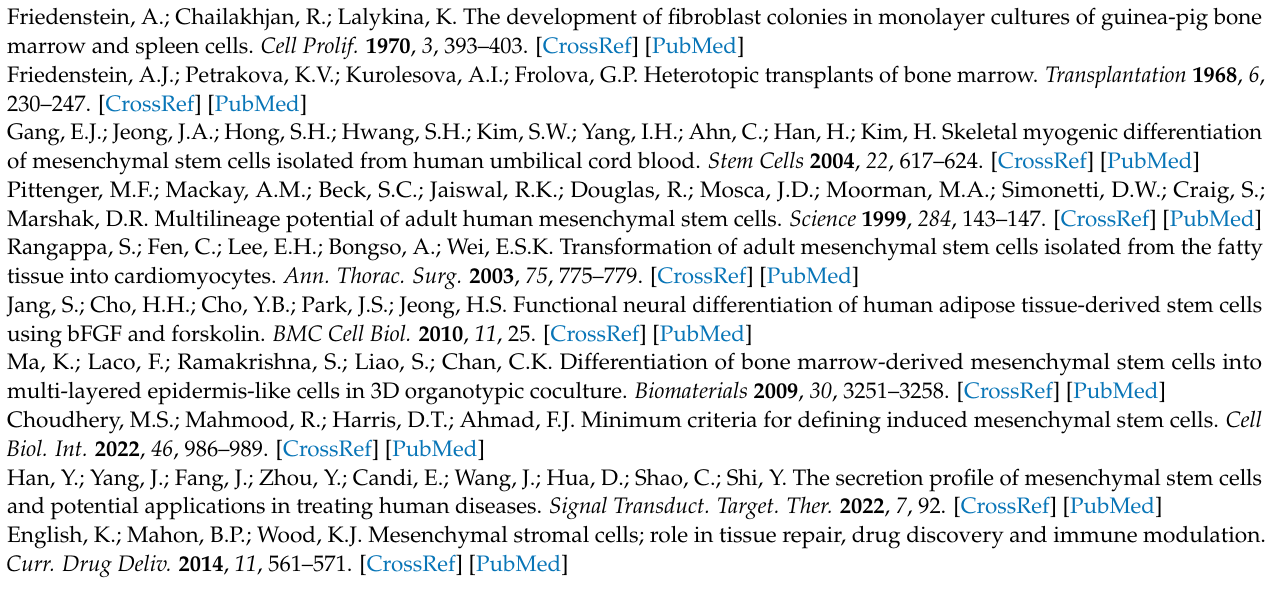
tary Table S5: List of primers, Supplementary Table S6: Cell counts and population doubling